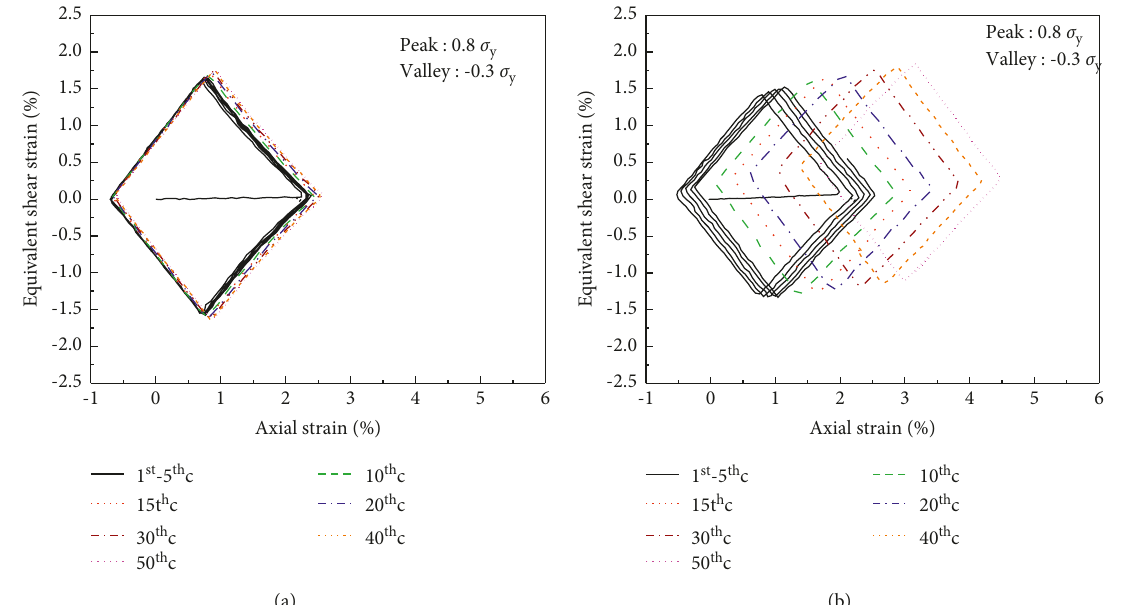
Figure 5: The curve of responding equivalent shear strain and axial strain of PC under the rhombic-type 1 loading path at different temperatures: (a) 35 ° C; (b) 90 ° C.